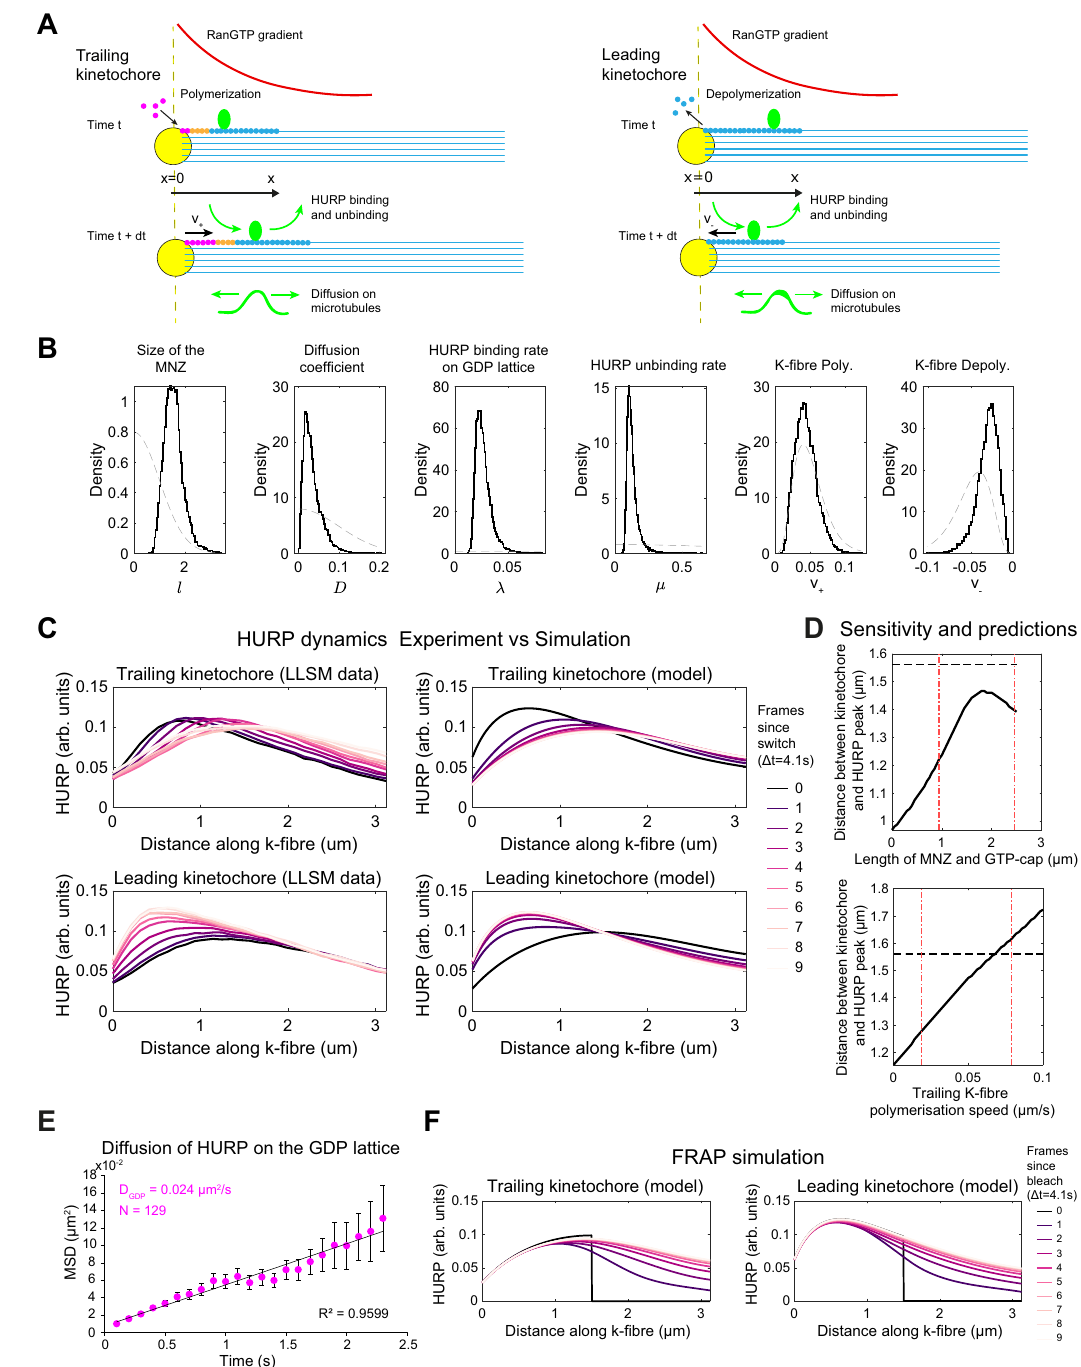
Fig. 6 | A minimal computational simulation of spatiotemporal dynamics of HURP recapitulates HURP-gaps. A Schematic showing the key components of the computational model of HURP dynamics on K- fi bres, including diffusion, binding and unbinding with rates dependent on the RanGTP gradient (red) and tubulin conformation (GTP — magenta, mixed-nucleotide zone — orange, GDP — blue), and polymerisation/depolymerisation at the kinetochore resulting in the advection of HURP. B Estimated distributions of key model parameters (histo- grams of posterior marginal distributions) based on data from Fig. 2C (see “ Methods ” ). Grey dashed lines indicate prior distributions (i.e., before learning from the data). C Spatiotemporal dynamics of HURP on K- fi bres from in vivo data (as in Fig. 2C) and computational model predictions using fi tted parameters (median of each posterior marginal distribution). D Sensitivity of the model to